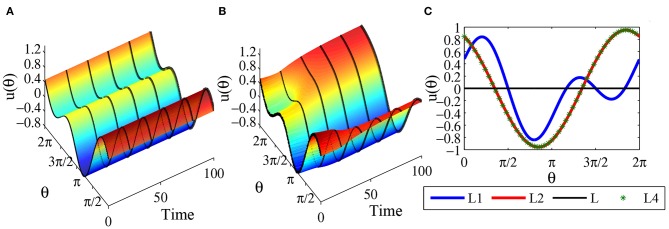
Equilibrium states for parameters a = 0, b = 3, and c = 2, which satisfy 0 < b < 2c and bc≠12. The network contains N = 1000 head-direction cells, τ = 1 and time step Δt = 0.1. (A) The time evolution of equilibrium solution (63) conforms that the state is stationary. (B) The time evolution of equilibrium solution (63) with disturbances in the initial state indicates that the equilibrium is unstable. (C) Comparison chart, where the blue line represents the equilibrium solution (63), the red line represents the final state starting from (63) after 100, 000 time steps, which matches perfectly with the one-peaked stable equilibrium solution u(θ)=bπcos(θ-6.5π42) as indicated by the green stars.